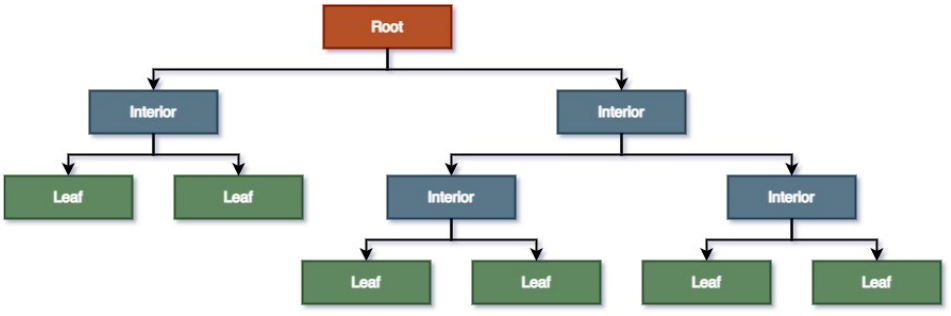
Figure 6. Terminology of a decision tree’s components with depth 3.